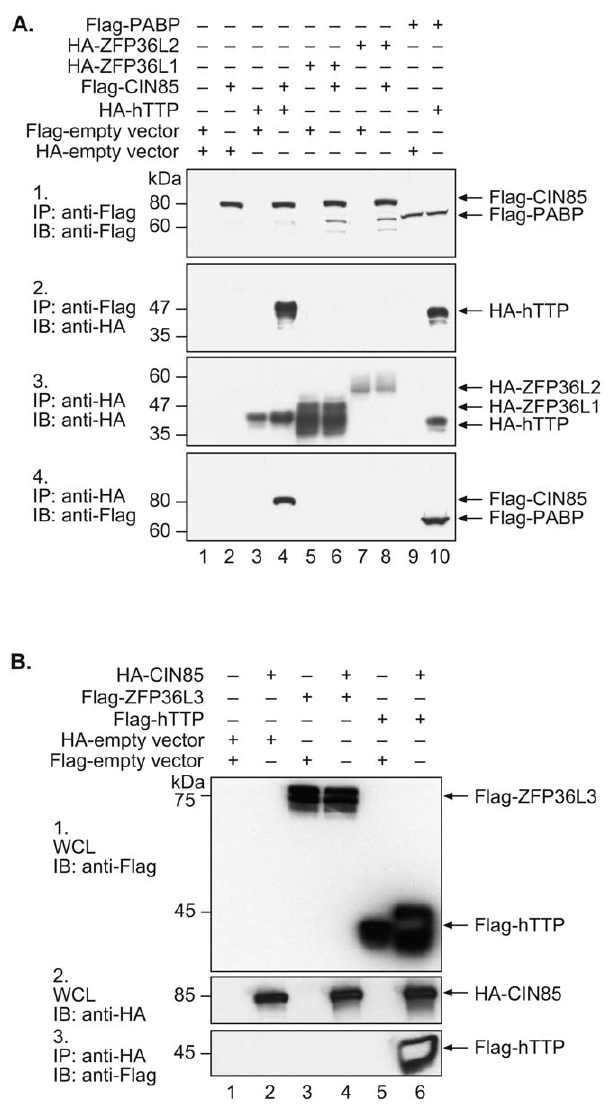
Figure 3. Association of CIN85 with hTTP family members. Abbreviations and other details are as described in the legend to Fig. 1, with the exception of Panel 3B1, which shows an immunoblot of the whole cell lystate probed with anti-Flag antibody.